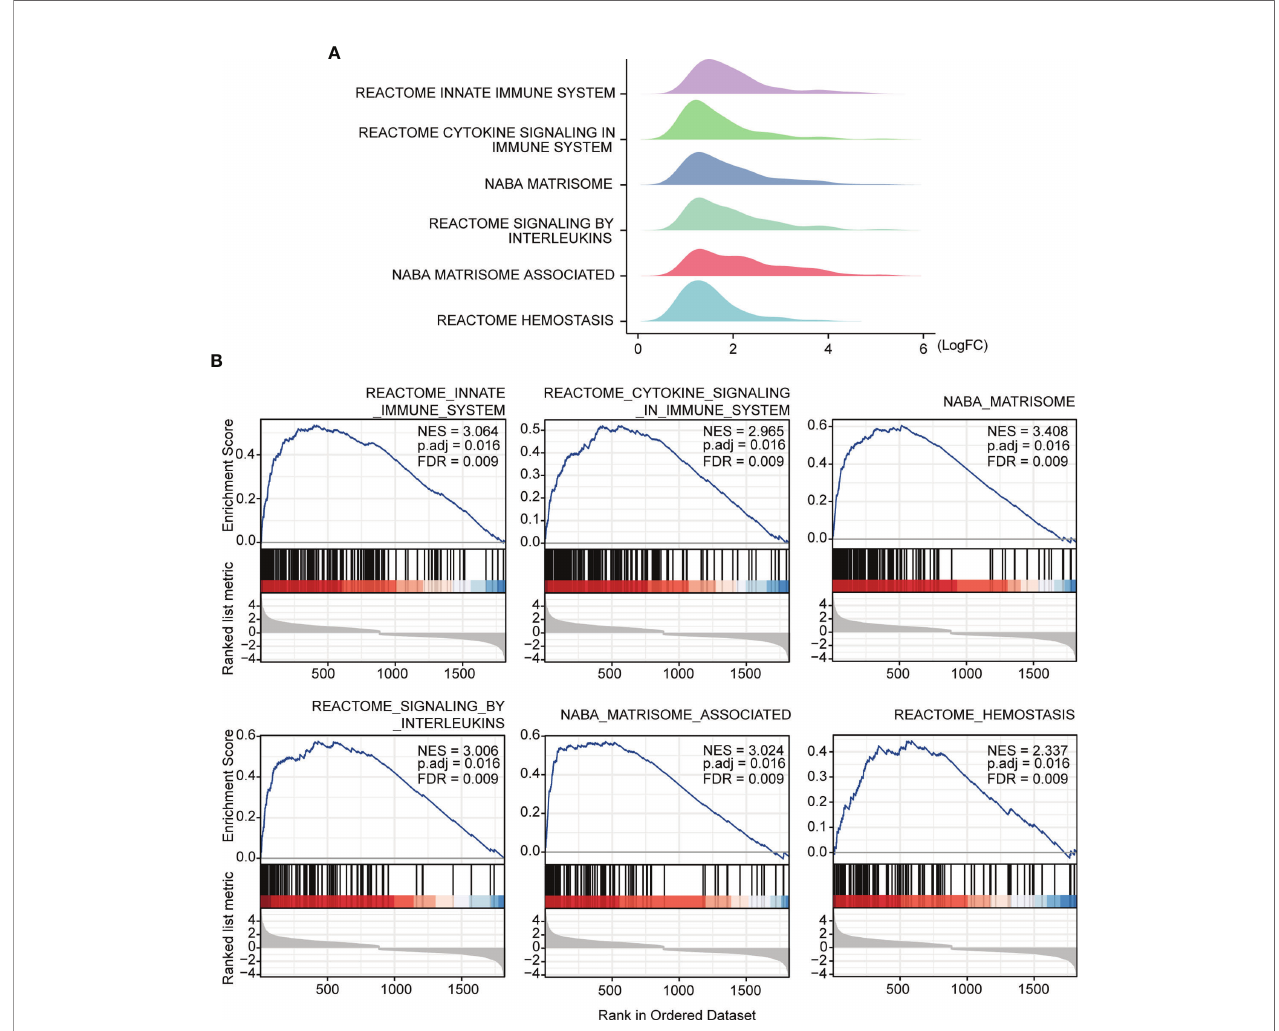
FIGURE 2 | GSEA annotation of gene sets. (A) Ridge plot show gene expression distribution in the immune-related annotated gene set. (B) Gene set enriched in the innate immunity system (FDR = 0.009, NES = 3.064, adj. p-value < 0.05), gene set enriched in cytokine signaling in immune system (FDR = 0.009, NES =2.965, adj. p-value < 0.05), geneset enriched in the NABA matrisome (FDR = 0.009, NES = 3.408, adj. p-value < 0.05), gene set enriched in signaling by interleukins (FDR = 0.009, NES = 3.006, adj. p-value < 0.05), gene set enriched in NABA matrisome associated (FDR = 0.009, NES = 3.024, adj. p-value < 0.05), gene set enriched in hemostasis (FDR = 0.009, NES = 2.337, adj. p-value < 0.05). Screening criteria for signi fi cant gene sets included adj. p- value < 0.05 and FDR < 0.25. NES: normalized enrichment